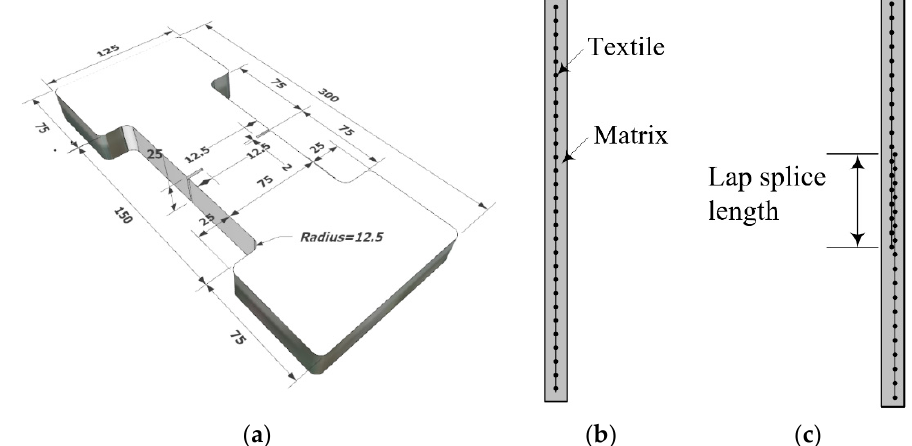
Figure 3. Coupon specimen for direct tensile test: ( a ) Dimensions (units, mm); ( b ) coupon without lap splice; and ( c ) coupon with a lap splice.